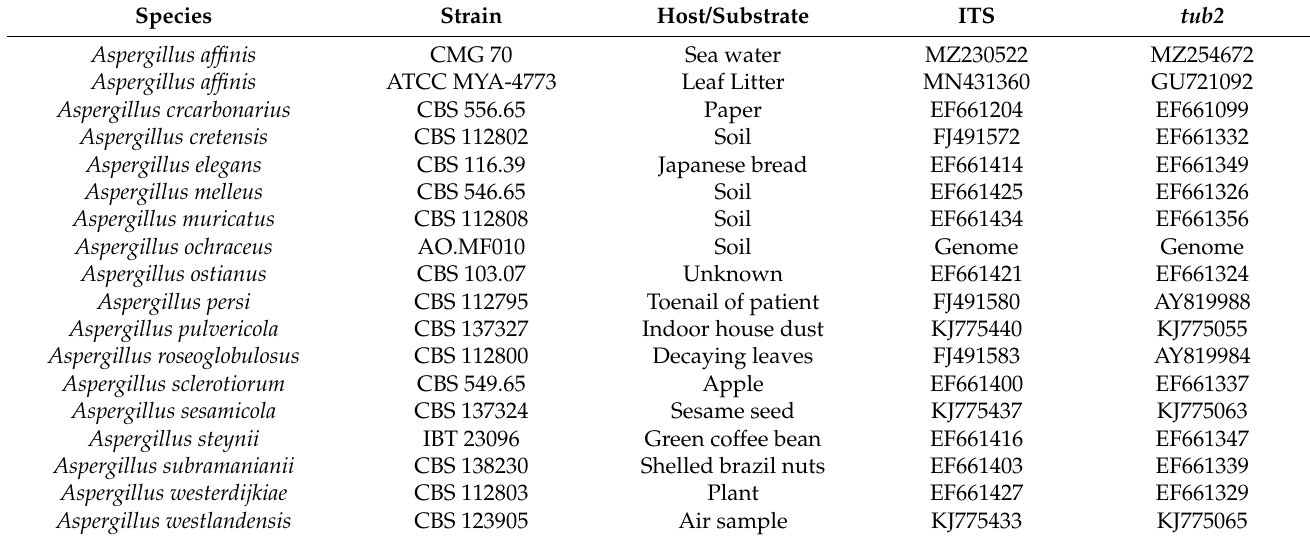
Table 1. List of Aspergillus species and strains used in this study. Accessions numbers of ITS and tub2 are provided.